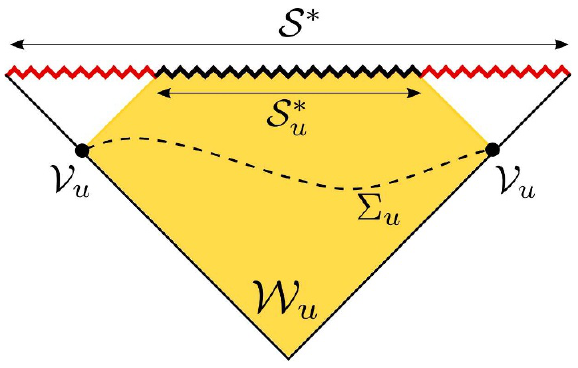
Figure 4 . The WdW patch W t , associated to the cut-off surface S ′ t , intersects the singularity at S ∗ t .